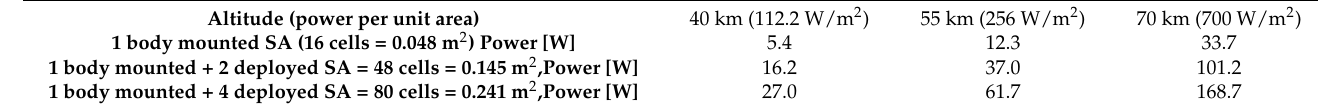
Table 7. Power generated by different solar array configurations at different altitudes. Altitude (power per unit